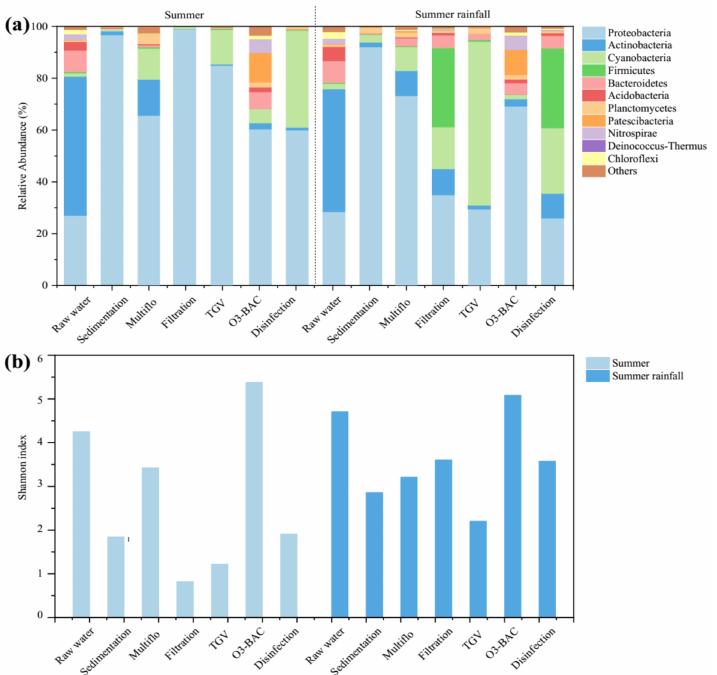
Figure 1. ( a ) Relative abundance of dominant taxa at the phylum level and ( b ) Shannon diversity index based on class identity OTUs in water samples at each treatment step before and after the rainfall event in summer.